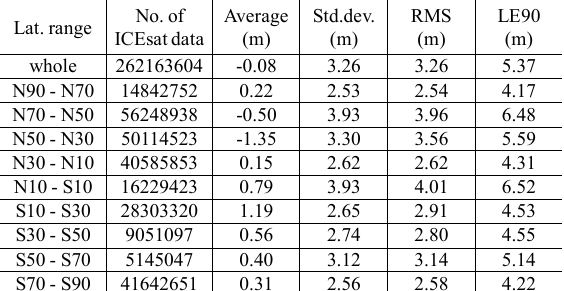
Figure 3. Distribution of mean errors (a) and error standard deviations (b) from ICESat data points for DSM-tiles. Table 3. Statistics of height difference (DSM-tiles minus ICESat data) for tiles in latitude-zones of 20 degree intervals as well as in whole